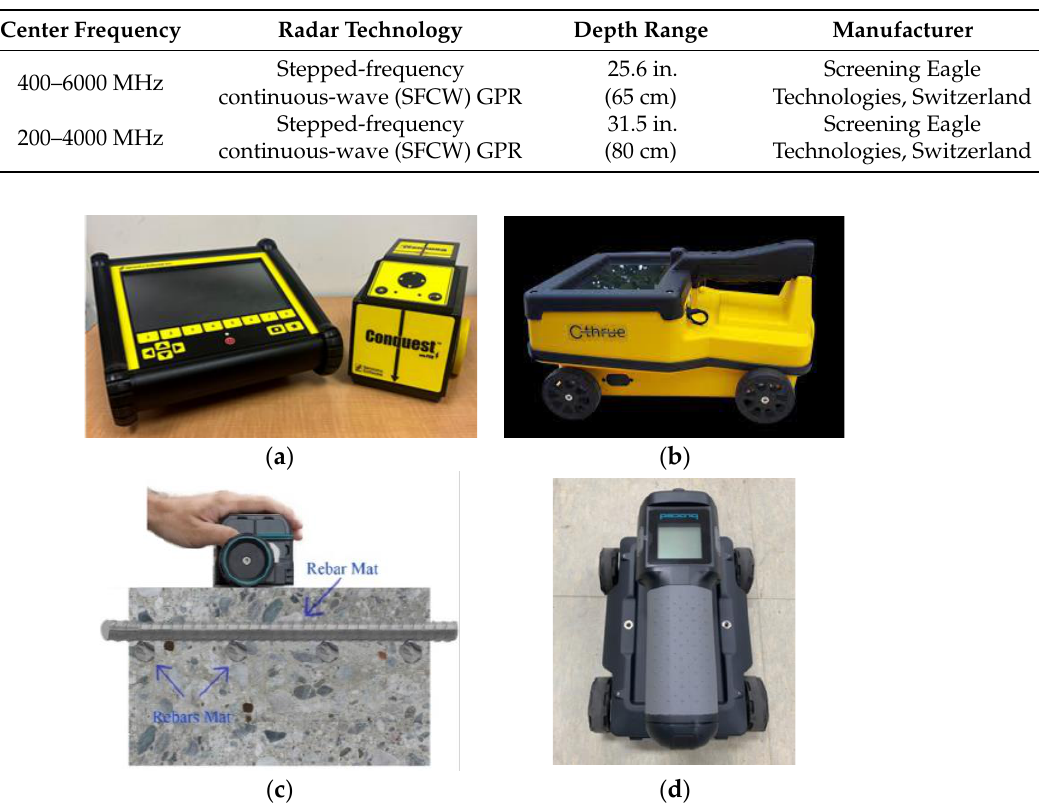
Table 3. Technical specifications of the GPR systems used [101–104].